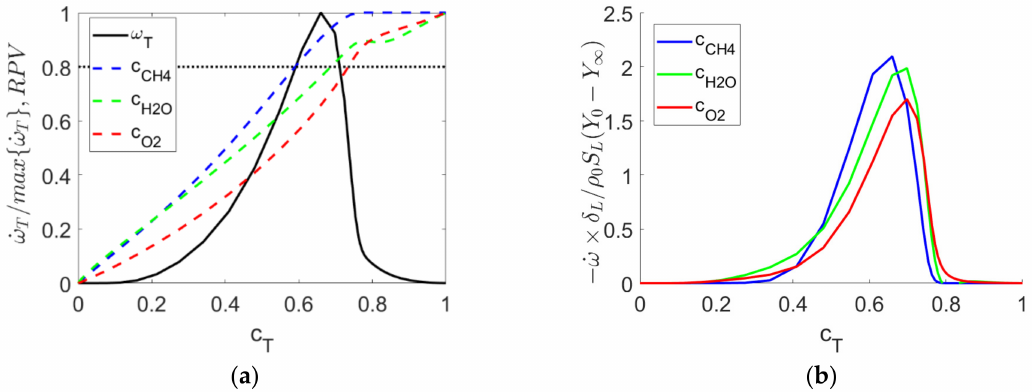
Figure 3. ( a ) Reaction progress variable based on CH 4 ,H 2 O,O 2 mass fractions versus reaction progress variable based on . . { ω T } . The dashed horizontal line corresponds to a reaction progress variable value of ω T / max temperature together with 0.8. ( b ) Magnitude of normalised reaction rates of major species versus reaction progress variable based on temperature. Results are taken from laminar flame simulations of a stoichiometric methane-air